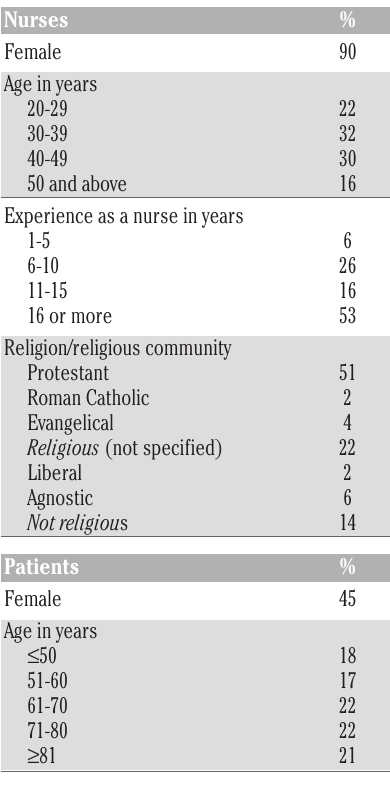
Table 2. Characteristics of nurses (n=51) and patients